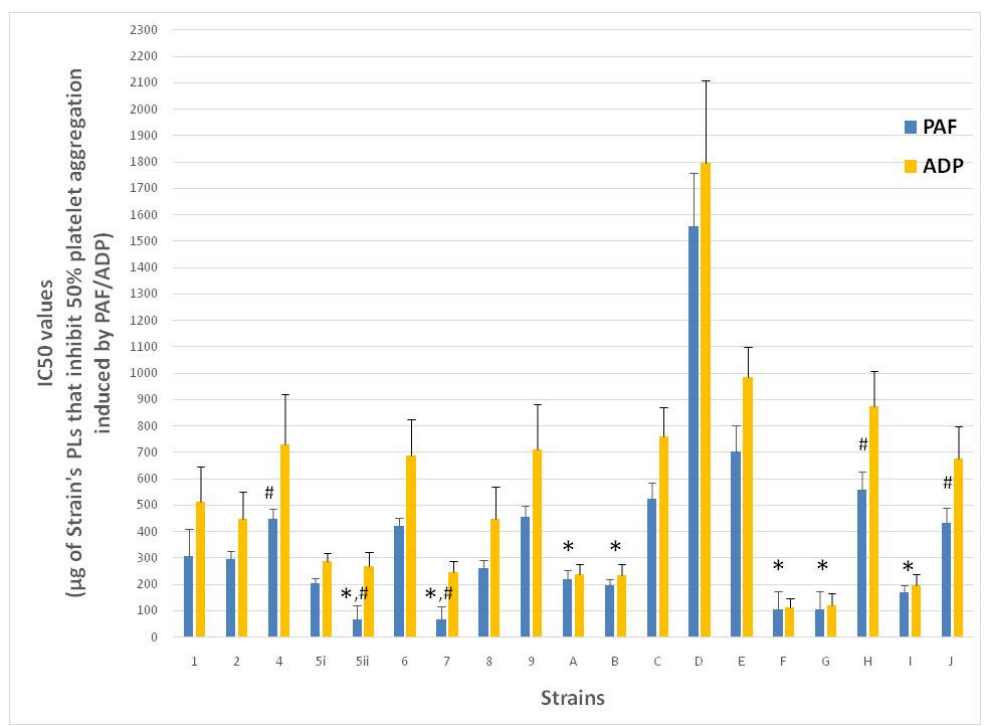
Figure 1. The anti-platelet potency of PL extracts from apple surface yeast strains (1, 2, 4, 5i, 5ii, 6–9) and apple must yeast strains (A–J), against human platelet aggregation induced by the inflammatory and thrombotic mediator PAF (blue bars) or by the platelet agonist ADP (yellow bars). Results are expressed as means of the IC50 (half-maximal inhibitory concentrations) values in µ g of PL in the aggregometer cuvette that causes 50% inhibition of PAF/ADP-induced platelet aggregation (the lower the IC50 value for a lipid extract the higher its inhibitory effect against the specific agonist of platelet aggregation). * denotes statistically significant difference ( p < 0.05) when the anti-PAF potency (IC50 value) of the bioactive PL extracts were compared within all strains assessed, while # denotes statistically significant difference ( p < 0.05) when the anti-PAF potency (IC50 value) of the bioactive PL extracts from each strain was compared with the relative anti-ADP potency for this strain. Abbreviations: PL, polar lipids; PAF, platelet-activating factor; ADP, adenosine 5 (cid:48)